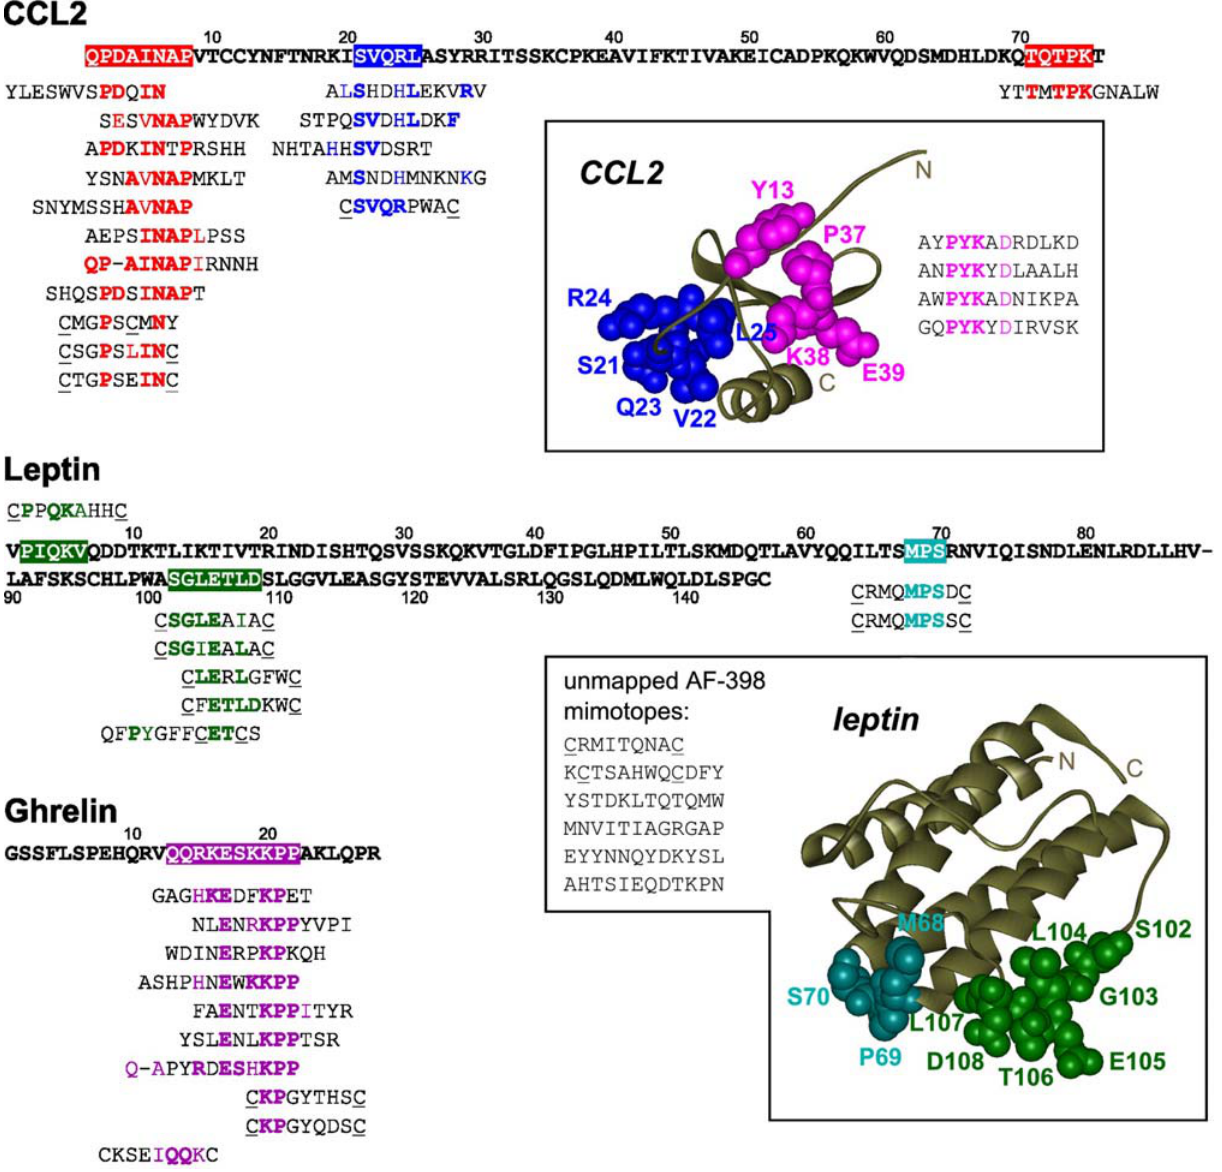
Figure 1: Affinity-selected epitope-mimicking peptides mapped to antigens’structures. Epitopes recognized by individual antibodies are color co- ded: red – ab9669, blue – AF-279-NA, pink – ab18678, green – AF-398, turquoise – MAB398, violet – sc-10368. In cyclized peptides cysteines for- ming disulfide bonds are underlined. Antigenic determinants bound by AF-279-NA, ab18678, AF-398 and MAB398 are depicted as space-filling models on ribbon diagrams of CCL2 (PDB code 3IFD) 17 and leptin (PDB code 1AX8).